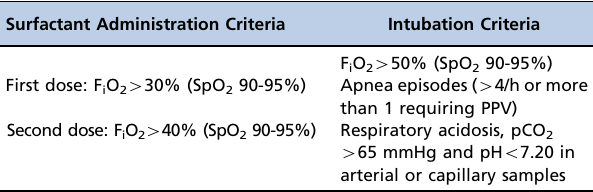
Table 1 - Surfactant administration and intubation criteria in preterm infants on nCPAP PEEP X 6cmH 2 O) (control and less invasive surfactant administration groups).